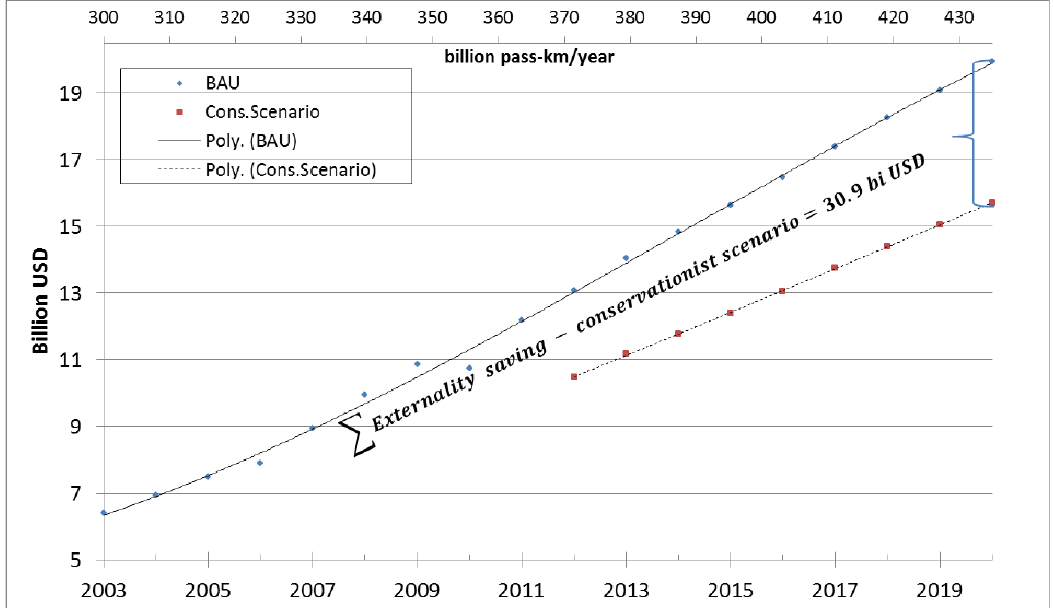
Figure 12. External Factors